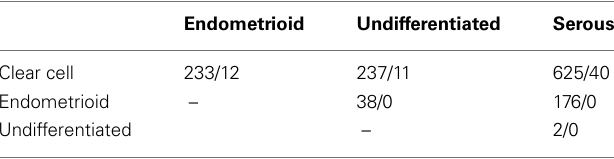
Table 2 | Pairwise comparisons of different histological types of ovarian cancer ( post hoc comparison,Tukey test)